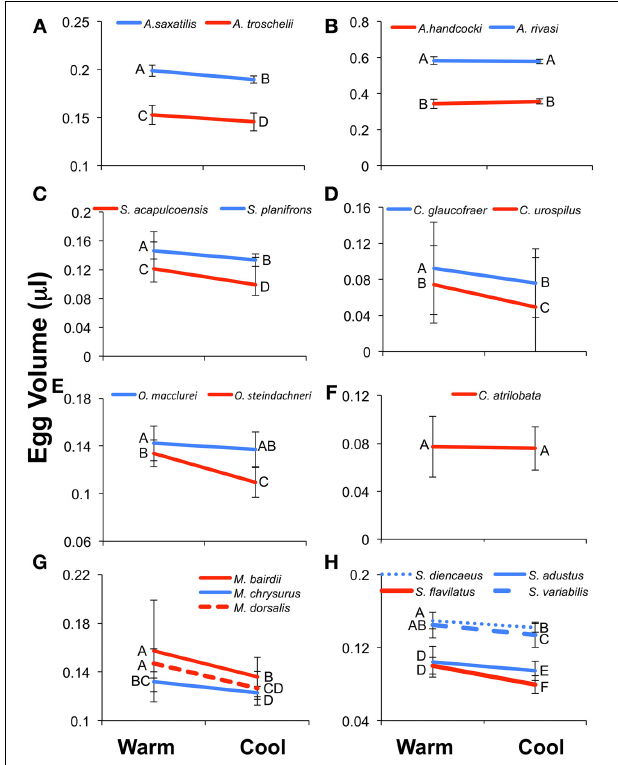
FIGURE 5 | Results of the Two-Way ANOVA showing the difference between species, the effect of season, and the interaction between the two facts on egg volume ( µ l). Results show the interaction plots from the 19 species included in Two-Way ANOVA. The Caribbean species is indicated in blue and the Pacific in red. Letters next to the data points indicated the results of the post-hoc Tukey’s HSD test, with values not connected by the same letter differing significantly from each other. Error bars indicate the standard deviation of the log-transformed data on which the analyses were conducted. The un-transformed means are presented for ease of comparison with other studies and the tables. (A) Abudefduf , (B) . Acanthemblamaria , (C) Stegastes (clade iii) , (D) Coryphopterus , (E) Ophioblennius , (F) Chromis , (G) Microspathadon , and (H) Stegastes (clade iv)